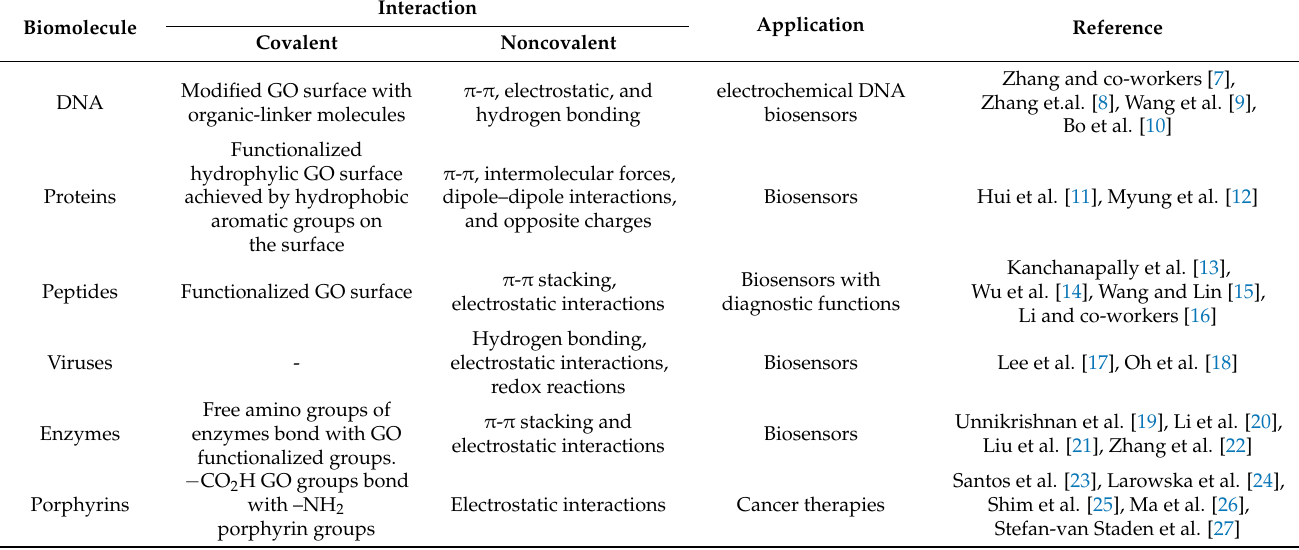
Table 1. Interactions between biomolecules and graphene and the main applications of each biomolecule. Interaction